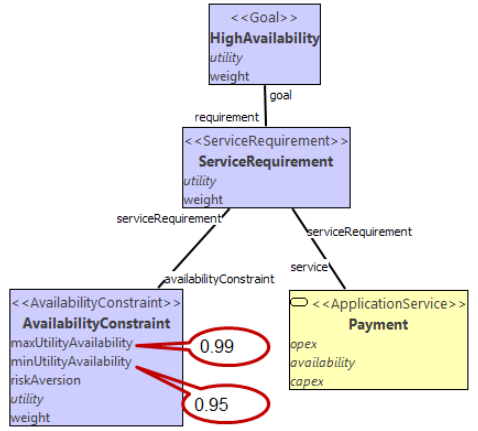
Figure 10. An example with multi-attribute utility and risk aversion. Parameters: k 0 : 01 ; k = 0 : 01 ; r = 2 ; r = 10 acc acc avail